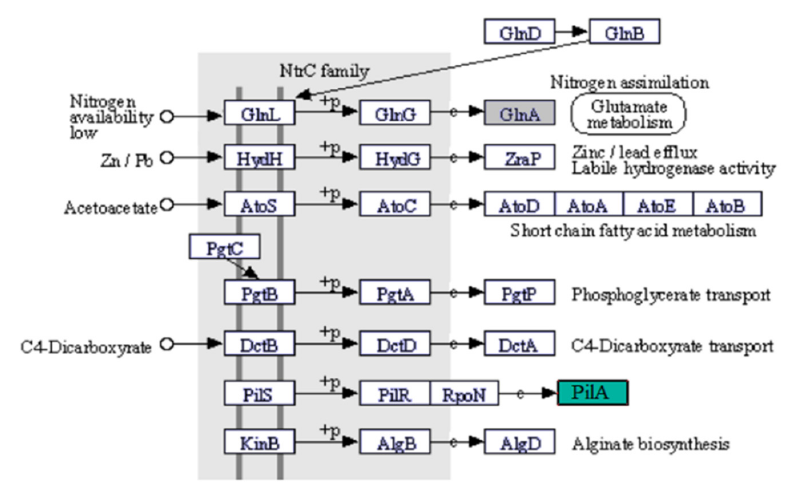
Figure 3. Two-component system pathway fragment from KEGG mapper, showing the expression of type IV pilus assembly protein (PilA) in the BPA sample (green) and glutamine synthetase (GlnA) in the control sample (grey).